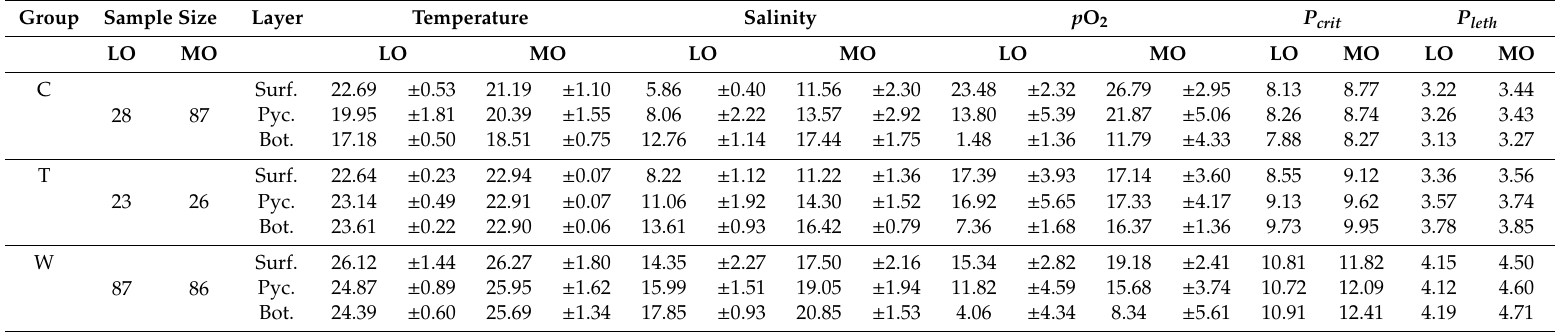
Table A5. Mean ( ± S.D.) temperature, salinity, partial pressure of dissolved oxygen ( p O 2 ) in three water layers (Surf. = above the pycnocline, Pyc. = within the pycnocline, Bot. = below the pycnocline), and the corresponding critical partial oxygen pressure ( P crit ) and lethal oxygen partial pressure ( P leth ) in each temperature (C = Cool, T = Temperate, and W = Warm) and dissolved oxygen subgroups (LO = less oxygenated, MO = more oxygenated). Sample sizes indicate the total numbers of CTD casts in each group. Bold p O 2 values indicate p O 2 < P crit (Biological hypoxia), and bold and italic values indicate p O 2 < P leth . Group Sample